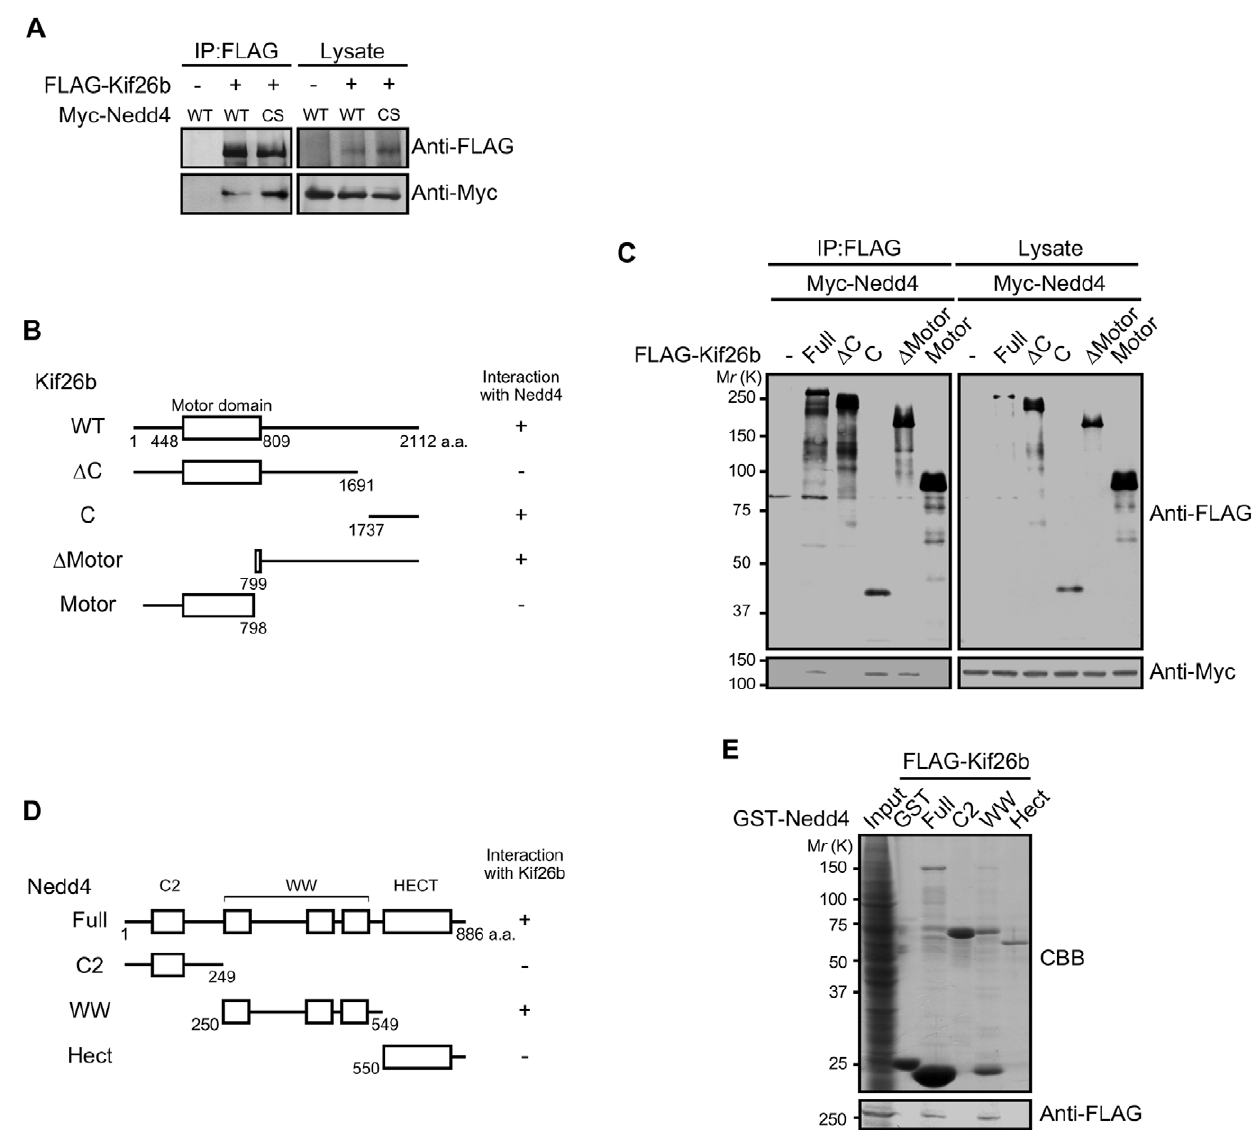
Figure 1. Identification of Nedd4 as a Kif26b-interacting protein. A . HEK293 cells were transfected with the indicated constructs. FLAG- tagged proteins were immunoprecipitated from the lysates with anti-FLAG beads. The precipitates were analyzed by immunoblotting with the indicated antibodies. B . Schematic diagrams of the Kif26b deletion constructs. Interaction with Nedd4 is summarized on the right of each construct: + , positive; 2 , negative. C . HEK293 cells were transfected with the indicated constructs. FLAG-tagged proteins were immunoprecipitated from the lysates with anti-FLAG beads. The precipitates were analyzed by immunoblotting with the indicated antibodies. D . Schematic diagrams of the Nedd4 deletion constructs. Interaction with Kif26b is summarized on the right of each construct: + , positive; 2 , negative. E . HEK293 cells were transfected with FLAG-Kif26b-expressing plasmids. The lysates were incubated with purified GST or GST-tagged Nedd4 deletions. The glutathione bead precipitates were analyzed by immunoblotting with the indicated